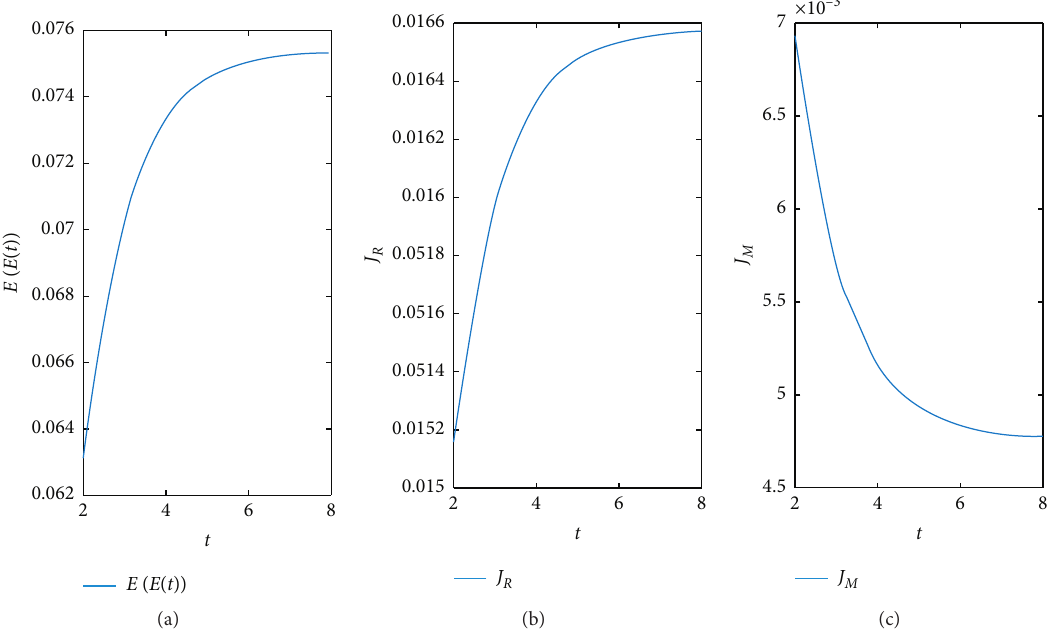
Figure 2: State variable trajectories under a cost-sharing and coordinated decision-making scenario.